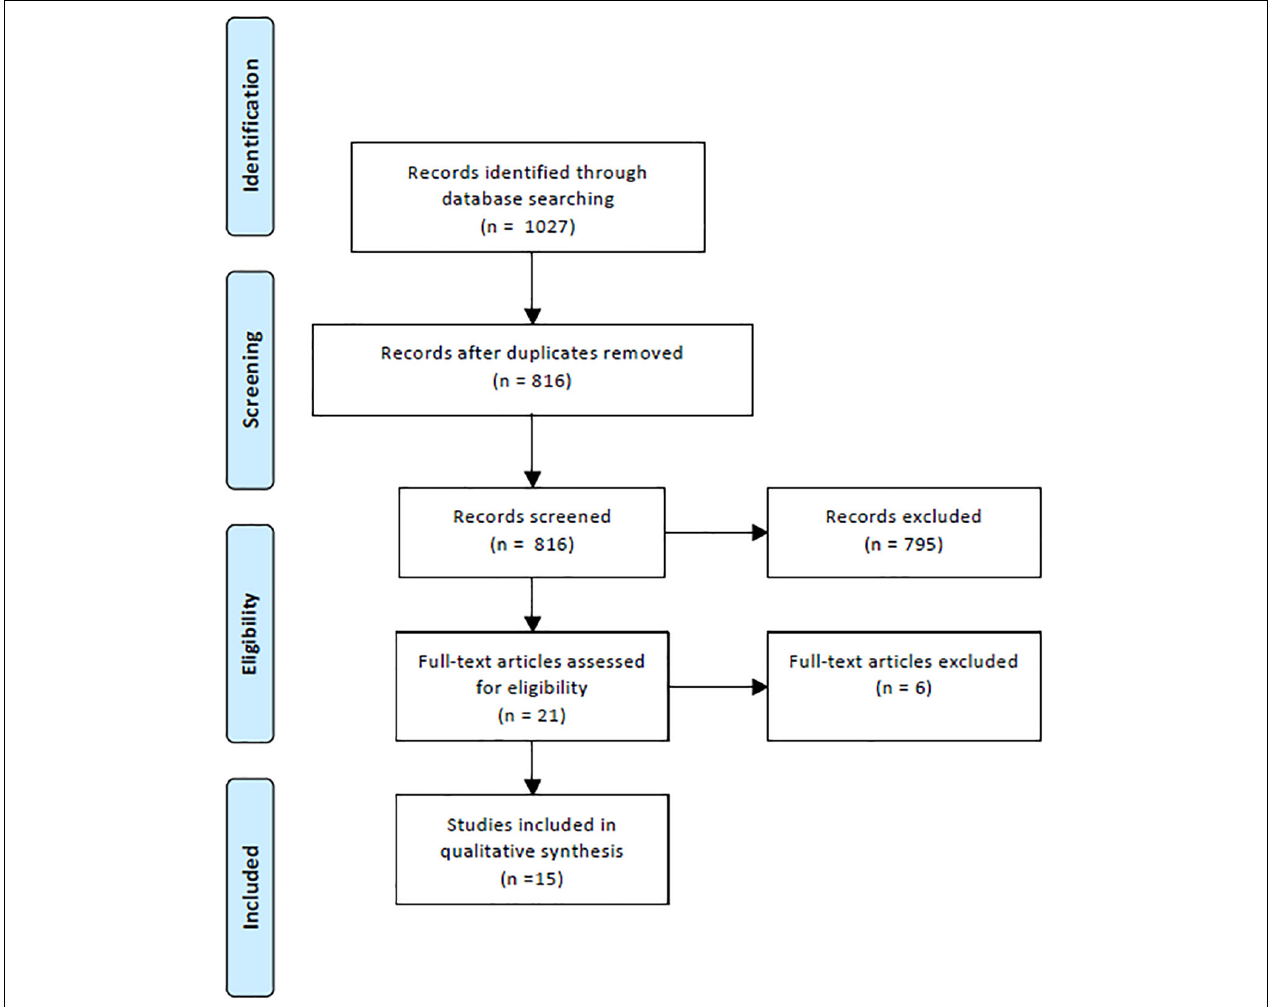
FIGURE 1 | Prisma flow